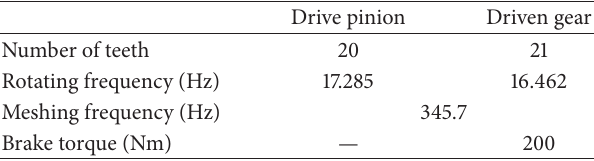
Table 1: Gearbox configuration and running